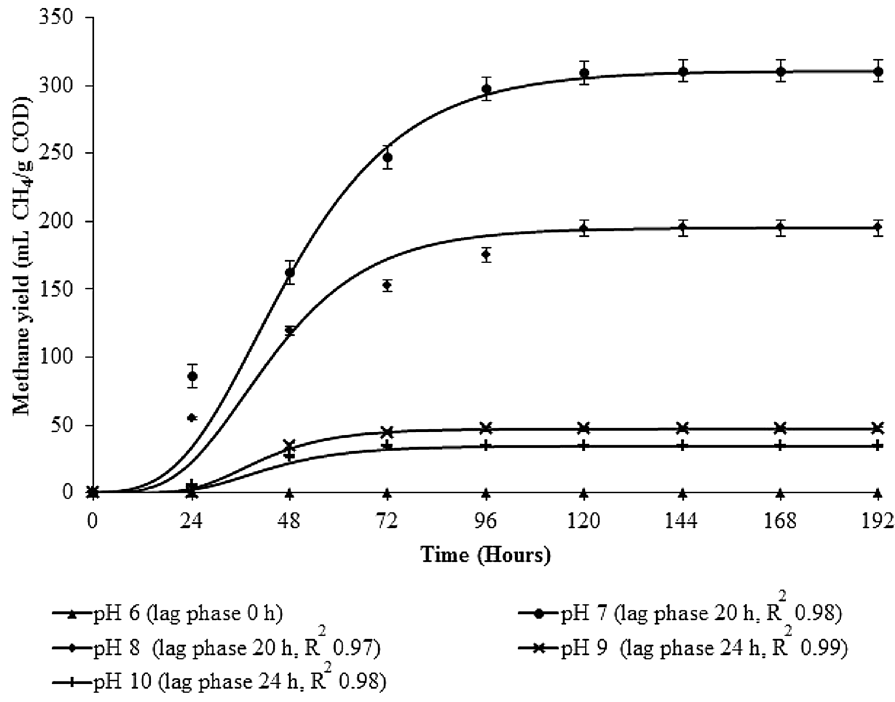
Fig. 3 Effect of initial